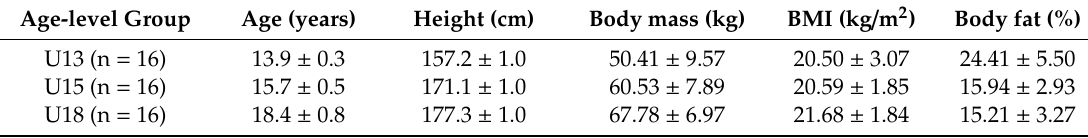
Table 1. Characteristics of the soccer players according to their age-level